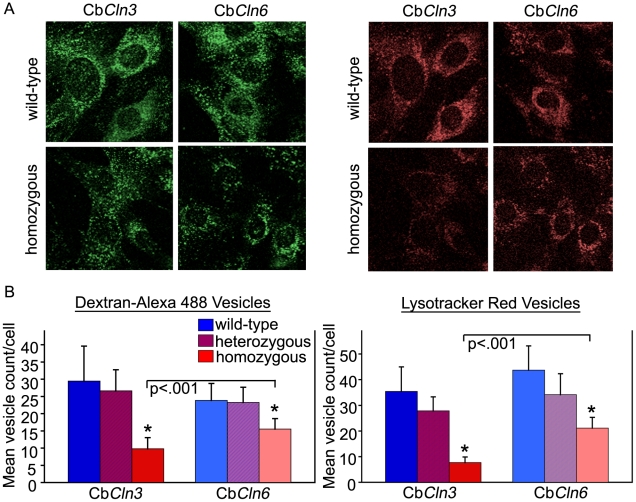
Altered fluid-phase endocytosis and LysoTracker® stain in homozygous CbCln3
Δex7/8 and CbCln6
nclf cells.
A. Representative micrographs of CbCln3 cells (wild-type and homozygous) and CbCln6 (wild-type and homozygous) cells stained with the fluid-phase endocytic marker, dextran Alexa-488 (green), and the lysosomal marker, LysoTracker®-Red (red), are shown. Reduced vesicular staining is evident in the homozygous cells, compared to wild-type cells for both CbCln3 and CbCln6 cells. However, note the differential distribution pattern of the labeled vesicles in homozygous CbCln3
Δex7/8 cells, compared to homozygous CbCln6
nclf cells. Labeled vesicles in homozygous CbCln6
nclf cells remain perinuclear localized, as they appear in wild-type cell lines. To the contrary, labeled vesicles in homozygous CbCln3
Δex7/8 cells appear less perinuclear localized, compared to wild-type cells and homozygous CbCln6
nclf cells. All images were captured at 40× magnification and were taken on the same day with identical settings. B. Bar graphs depicting quantification of labeled endosomes (left) and lysosomes (right) in CbCln3 cells (CbCln3
+/+ and CbCln3
Δex7/8/Δex7/8) and CbCln6 (CbCln6
+/+ and CbCln6
nclf/nclf) cells are shown. Mean vesicle count/cell was significantly reduced (*p<.001) in both homozygous CbCln3
Δex7/8and CbCln6
nclf cells, compared to the respective wild-type or heterozygous cell lines. A student's t-test also revealed a significant difference (p<.001) between the homozygous cell lines of differing genotype (i.e. CbCln3
Δex7/8/Δex7/8 versus CbCln6
nclf/nclf), which was suggestive of a more dramatic reduction of stained vesicles in the CbCln3
Δex7/8/Δex7/8 cells.